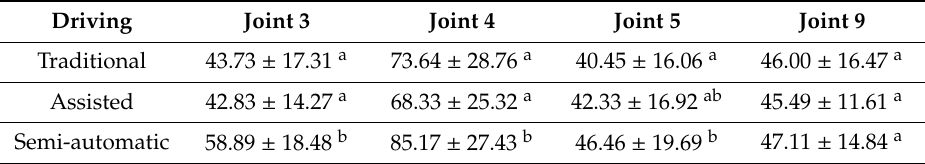
Table 4. The average AcD (m) measured in the four joint points between the resting and the working positions during the field